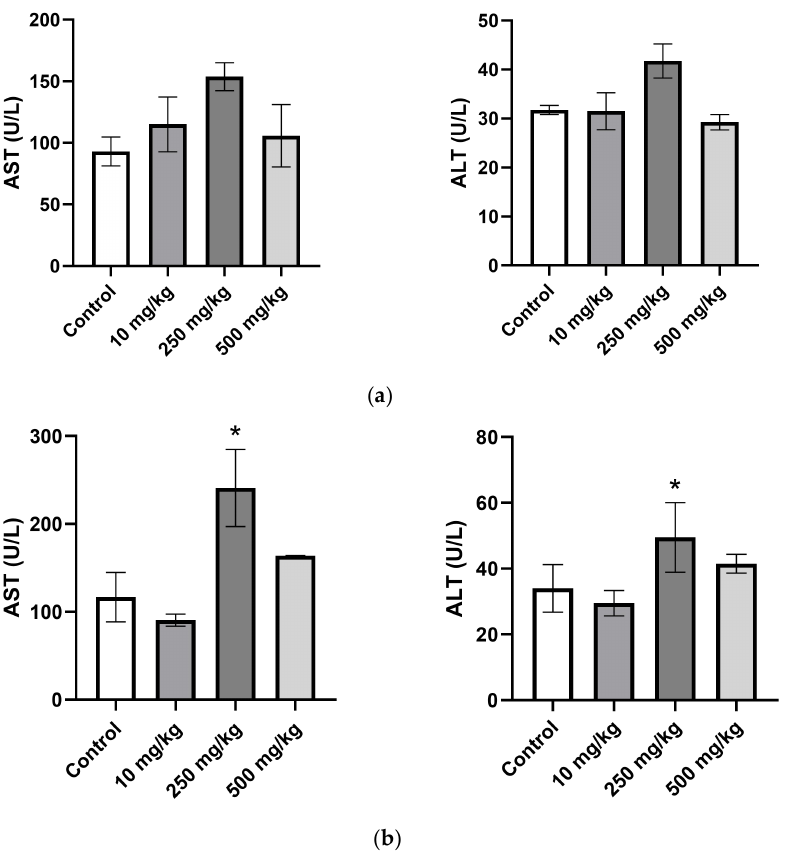
Figure 6. Comparison of the plasma liver enzymes levels in PsA versus vehicle control-treated Swiss albino mice. ( a ) AST and ALT in plasma of male mice. ( b ) AST and ALT in plasma of female mice. Data shown as mean ± SEM for n = 5/sex/group. * indicates a statistical significance at p < 0.05.